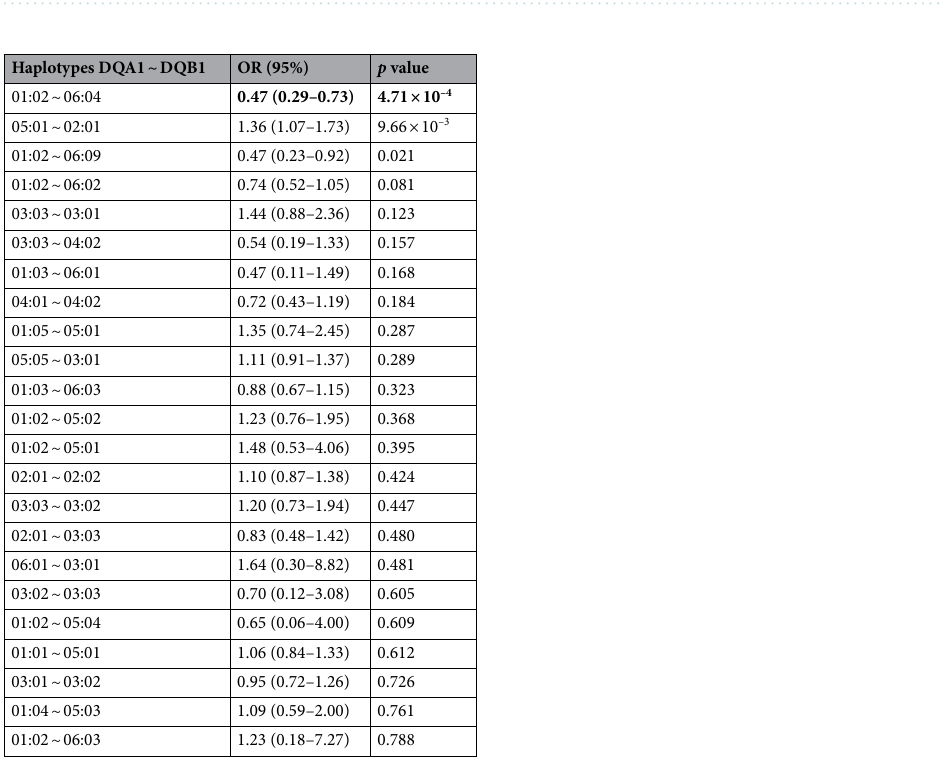
Table 4. Results of the HLA haplotype assessment after meta-analysis. Association test based on a chi-square test. CI = confidence interval, OR = odds ratio. In bold, the haplotype that exceeds the threshold established after Bonferroni correction ( p = 2.17 × 10 –3